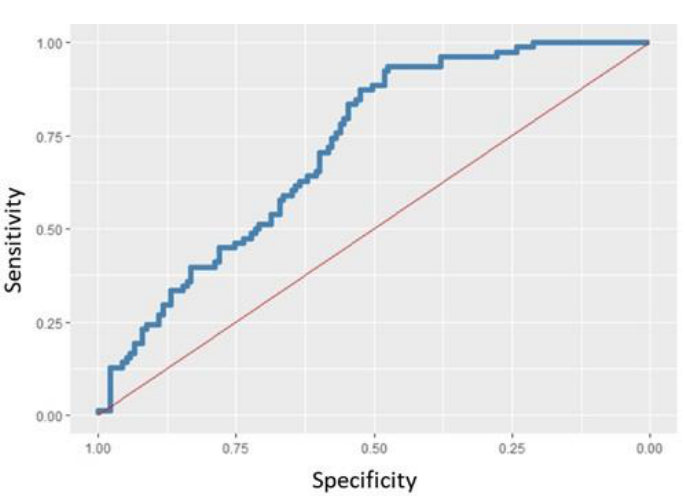
Figure 4. Box plot of age ( a ) and BMI ( b ) as a function of eruption symmetry.